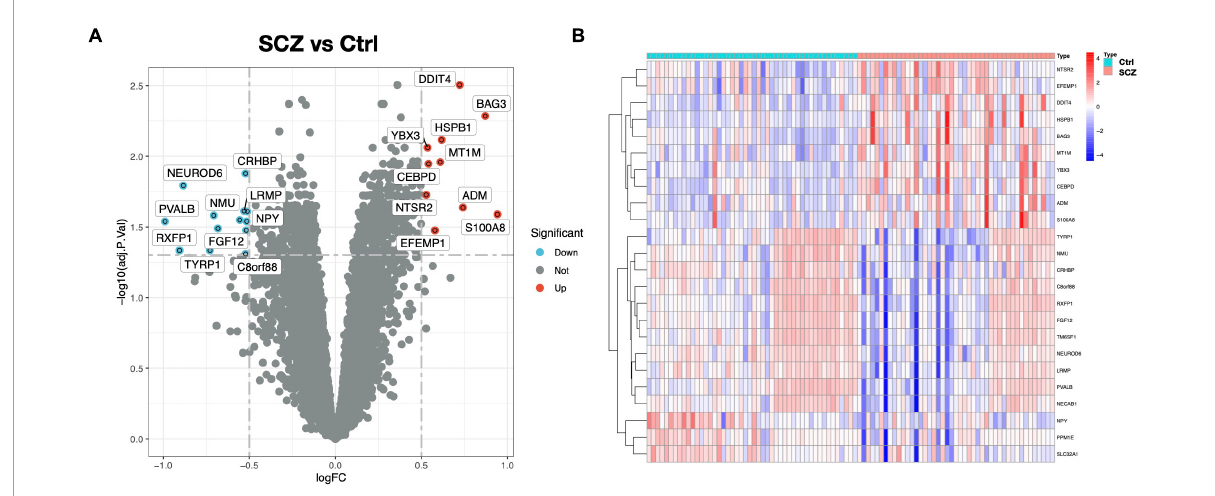
FIGURE2 DEG screening between SCZ and healthy control. (A) Volcano graphic visualizing DEGs of SCZ and normal samples. (B) Heatmap of DEGs among normal and SCZ samples.